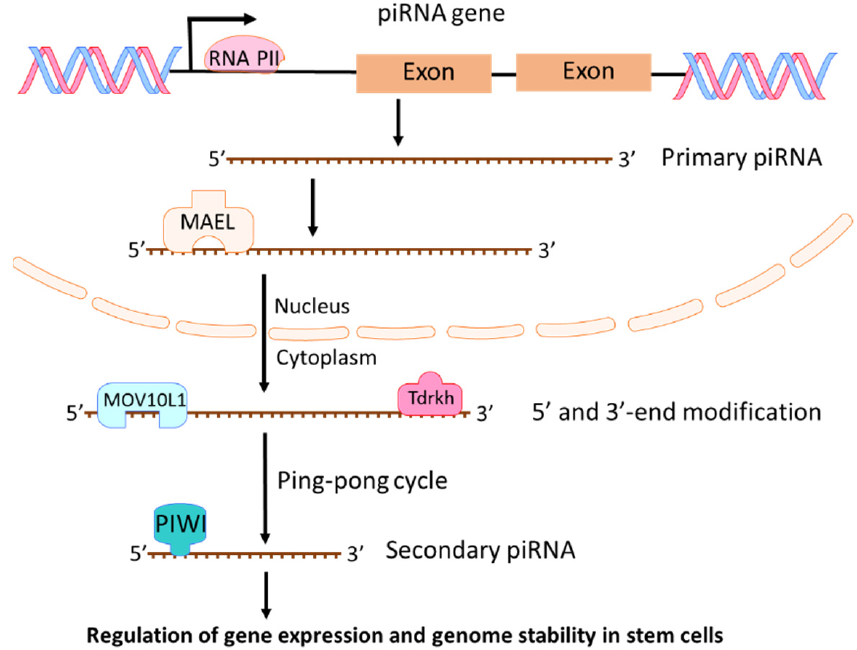
Figure 4. Biogenesis and functions of piRNAs. Primary piRNA is transcripted by RNA polymerase II (Pol II) from piRNA genes. By binding to MAEL, the primary piRNA is transported into cytoplasm where the primary piRNA undergoes 5 ′ and 3 ′ -end modification and a ping-pong cycle to create secondary piRNAs. piRNAs can regulate gene expression and genome stability in stem cells.